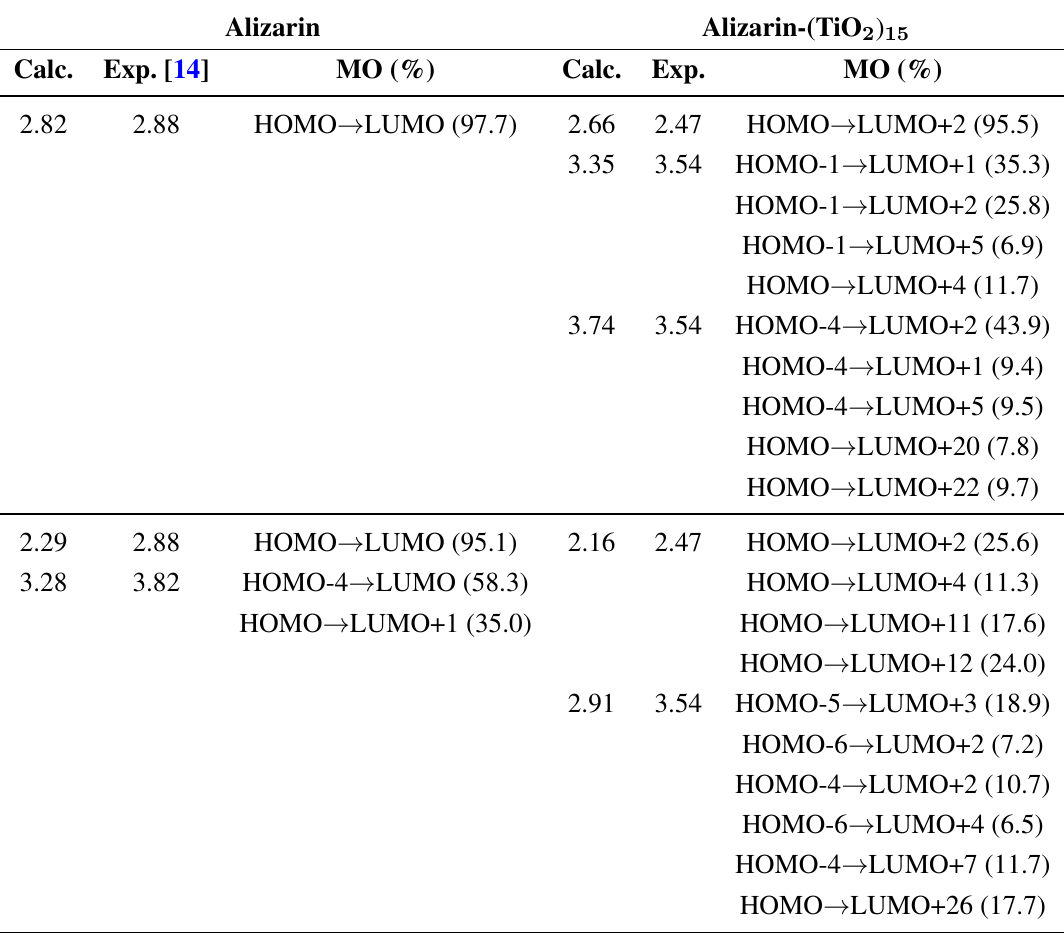
Table 1. Calculated (Calc.) and experimental (Exp. [14]) excitation energies in eV, active molecular orbitals (MO) and their contributions in %. Top panel: time-dependent density functional theory (TDDFT)/Becke three-parameter-Lee-Parr-Yang (B3LYP); bottom panel: TDDFT/Perdew-Burke-Ernzerhof